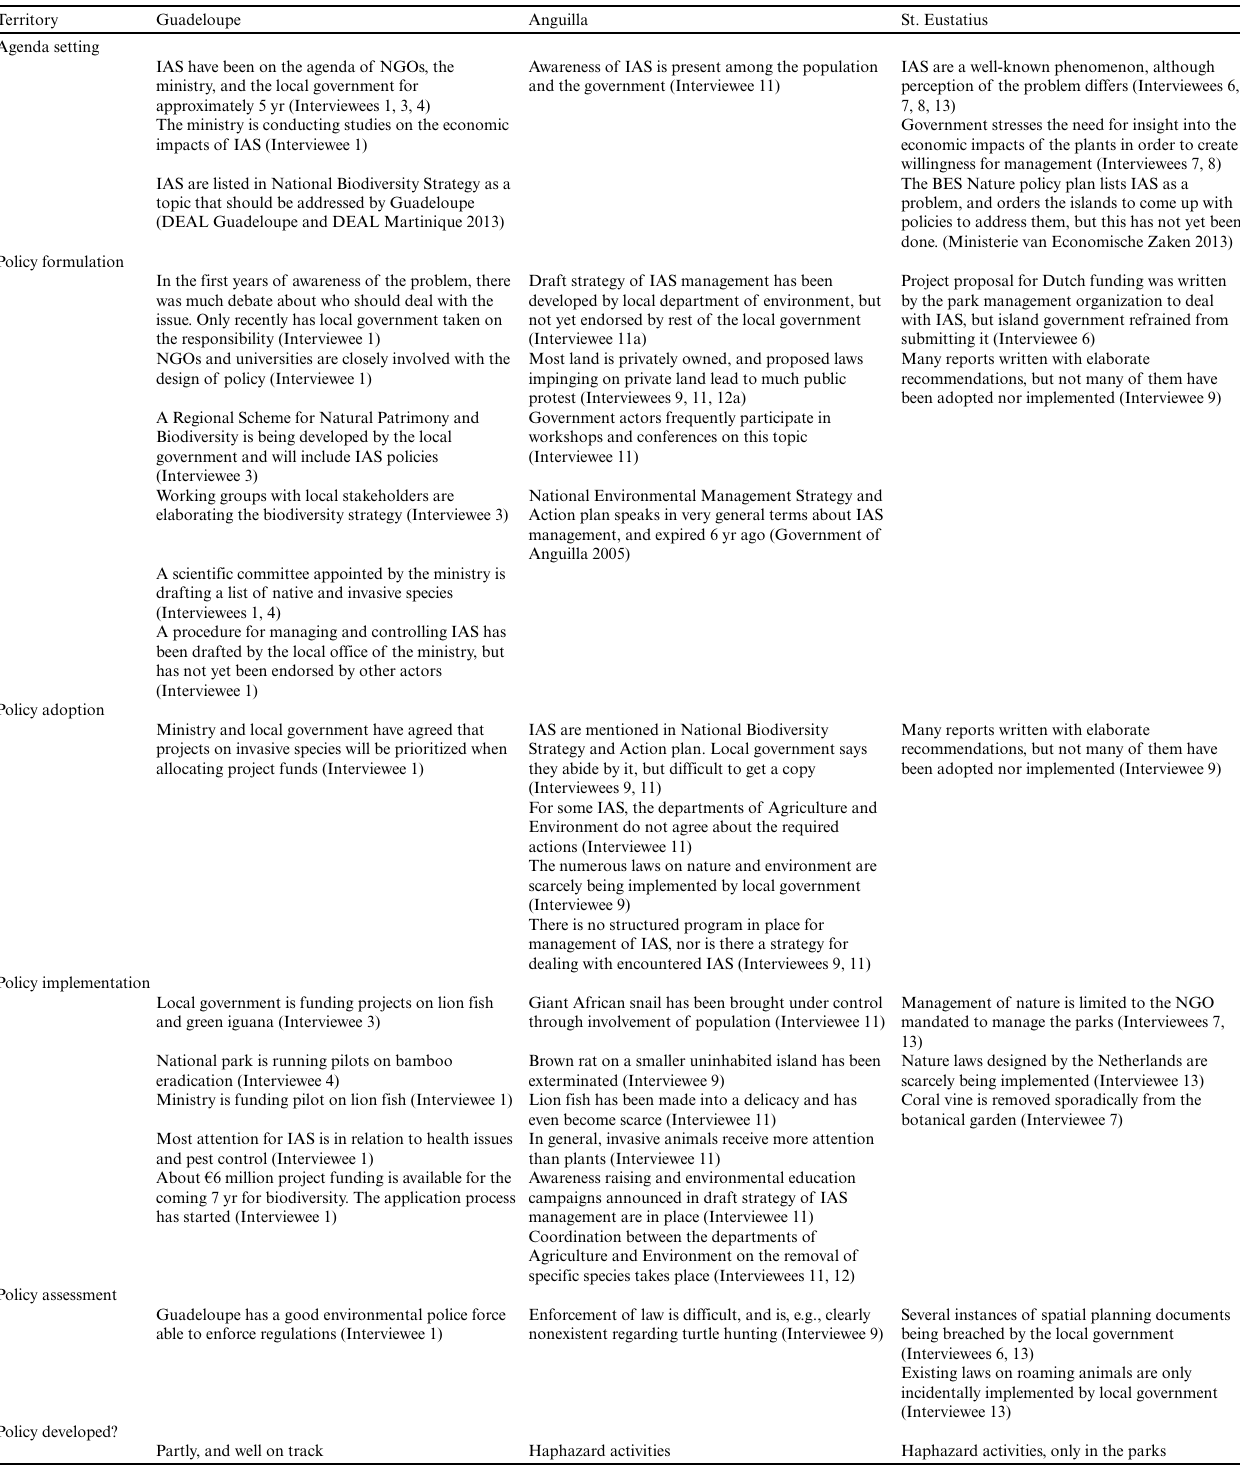
Table 2. Findings regarding policy development on IAS in the three cases